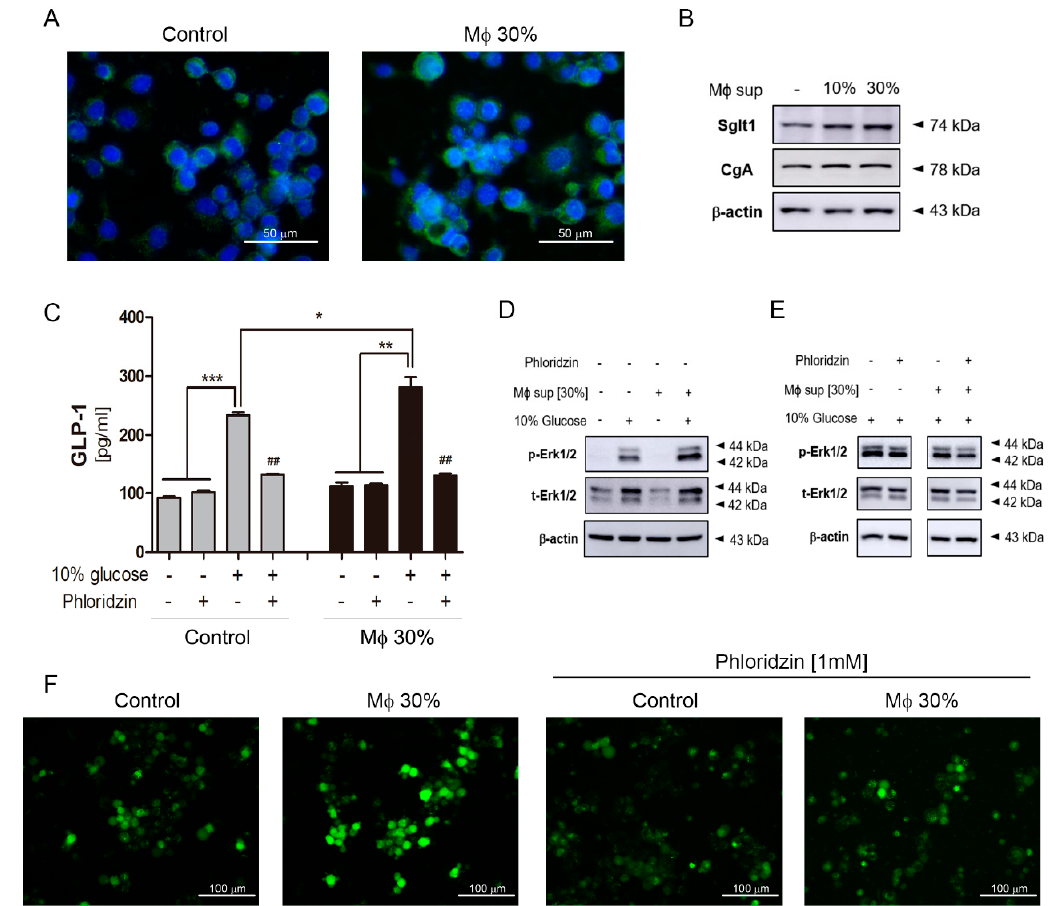
Figure 5. The inflammatory condition induced an increment of Na + -glucose co-transporter Sglt1 in differentiated NCI-H716 cells. Fluorescence of Sglt1 in differentiated NCI-H716 cells ( A ). Scale bars represent 50 µ m. Sglt1 increased after incubation with conditioned media (M φ 30%) in a dose-dependent manner ( B ). GLP-1 secretion in response to 10% glucose in NCI-H716 cells ( C ). Gray bar: Control group; black bar: incubated group with conditioned media. Glucose exposure induces ERK phosphorylation ( D ) and ERK phosphorylation is slightly reduced by incubation with phloridzin ( E ). * p < 0.05, ** p < 0.01, *** p < 0.001. Student’s t -test. Images of Fura-4AM fluorescence in differentiated NCI-H716 cells after incubation with 10% glucose and showing effect of 1 mM Phloridzin ( F ). Scale bars represent 100 μ m.